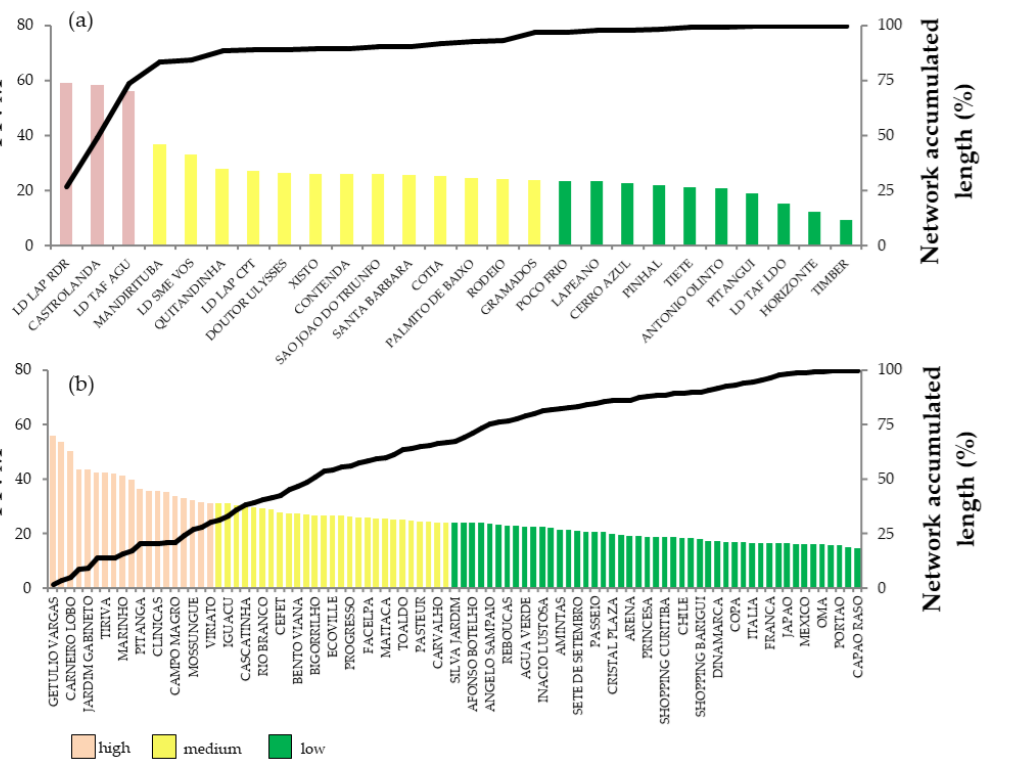
Figure 6. PIVM ( a ) obtained for urban site (S1); ( b ) Rural sites (S2, S3, and S4). The PIVM value ranged between 14.53 and 55.99, with 19 feeders classified as